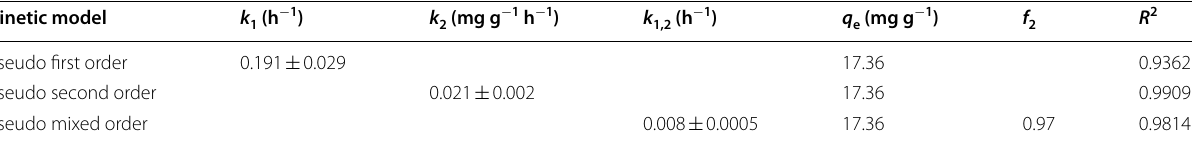
Table 2 Parameters of kinetic models obtained using CV for adsorption of Cr(VI) on C Kinetic model